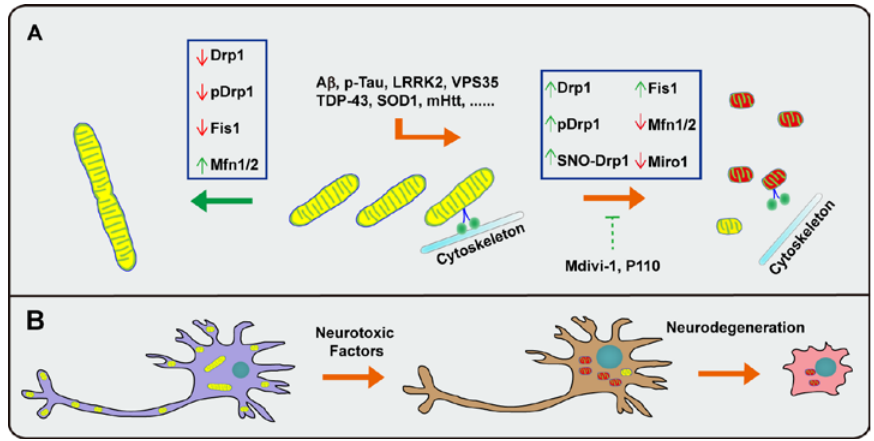
Figure 2. Impaired mitochondrial dynamics in neurodegenerative diseases. ( A ) Mitochondrial fragmentation is a common factor in neurodegeneration, leading to impaired mitochondrial function and increased cell death. Disease- associated proteins such as phosphorylated Tau, Aβ, LRRK2 G2019S, SOD1 G93A, and mutant Htt disturb the delicate mitochondrial dynamics, including fusion, fission, and trafficking, resulting in mitochondrial dysfunction. Manipulation of mitochondrial dynamics by genetic or chemical approaches may be a useful strategy to restore mitochondrial function and promote neuronal survival; ( B ) Mitochondrial dynamic abnormalities impair mitochondria transport and proper localization, leading to mitochondrial depletion in neurites and synapses and eventually neuronal